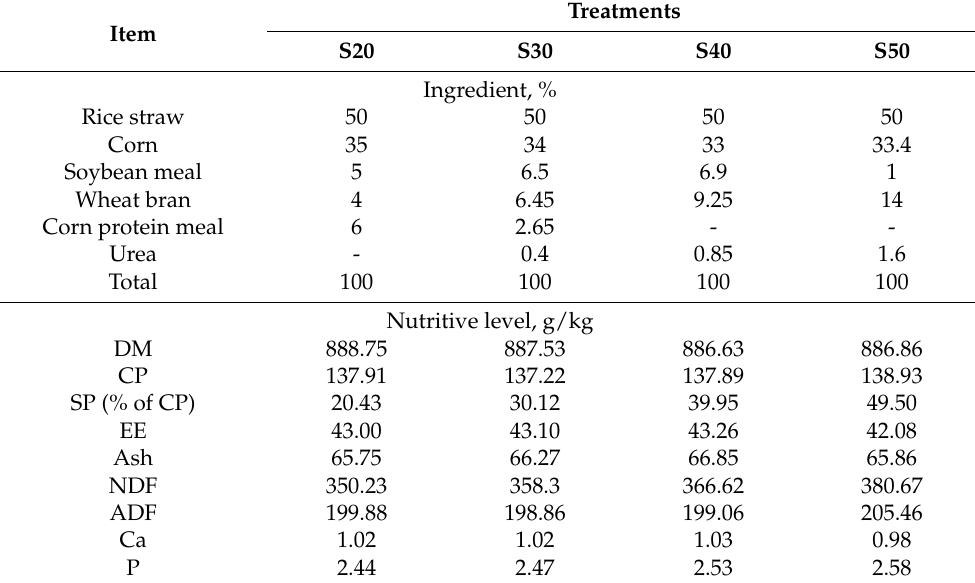
Table 1. Substrate composition and nutrient